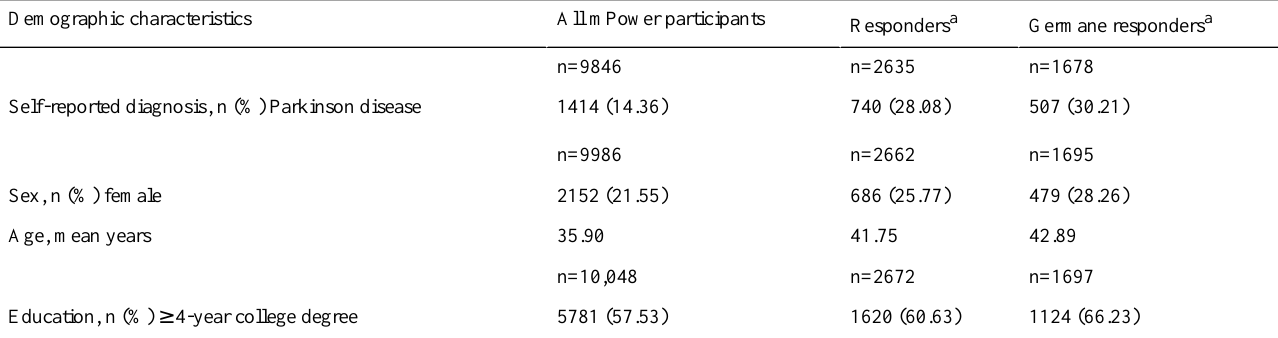
Table 2. Demographic characteristics of participants completing one or more demographic survey questions: all mPower participants versus responders and all mPower participants versus germane